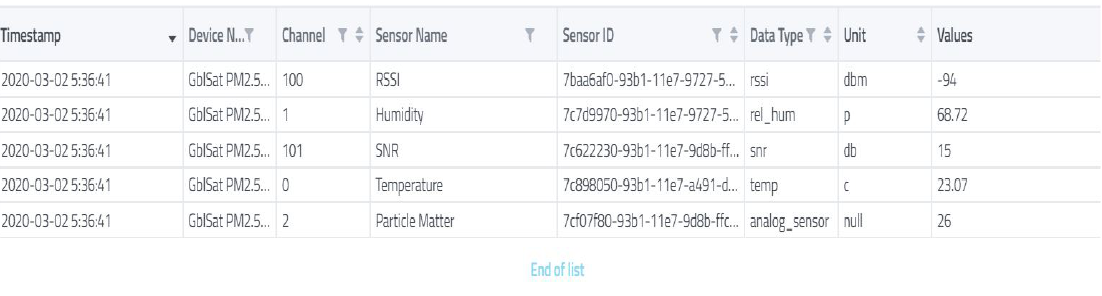
Figure 21. Sensors Information on application server from the gateway prototype: